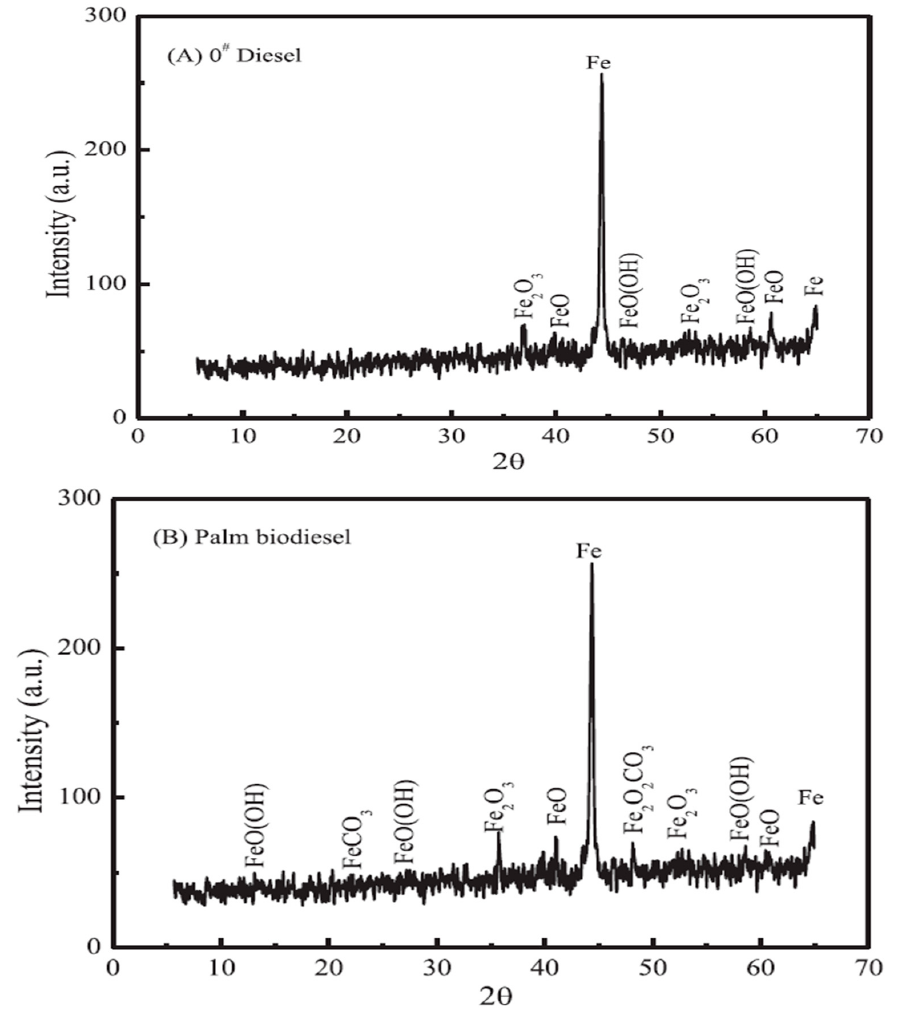
Figure 11. Corrosion products formed on MS at #0 diesel and biodiesel [66]. Energies 2021 , 14 , x FOR PEER REVIEW